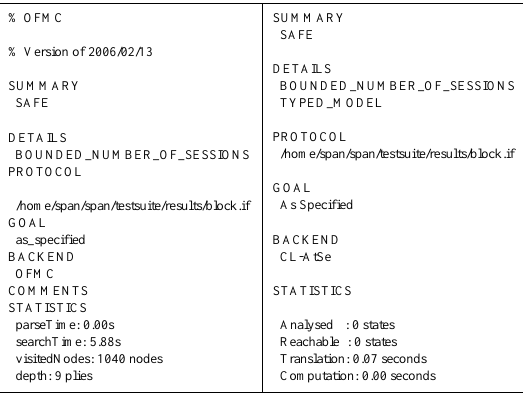
Figure 13. Automated Validation of Internet Security Protocols and Applications (AVISPA) analysis result using OFMC and